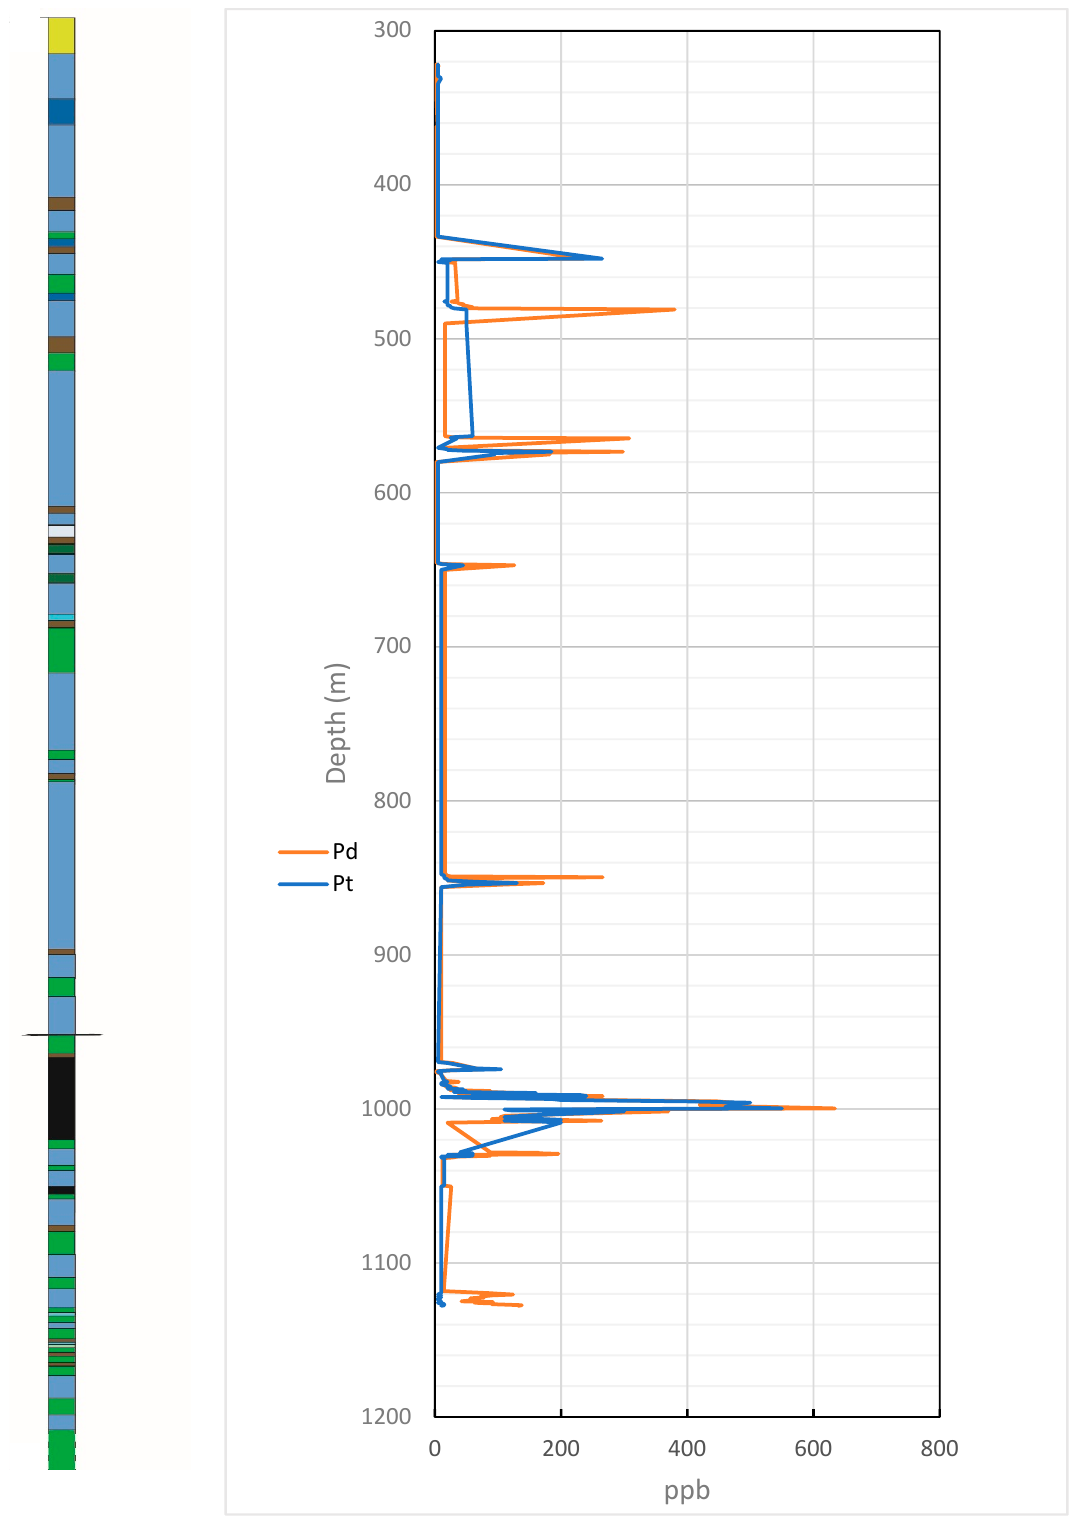
Figure 5. The layered ultramafic ‐ mafic succession observed in the Echo Lake intrusion and locations of the zones of platinum group element (PGE) ‐ enrichment in the intrusion. The magnetite ‐ bearing olivine gabbro shows peak concentrations. The most highly mineralized interval between 970 m and 1050 m has been expanded in Figure 6.